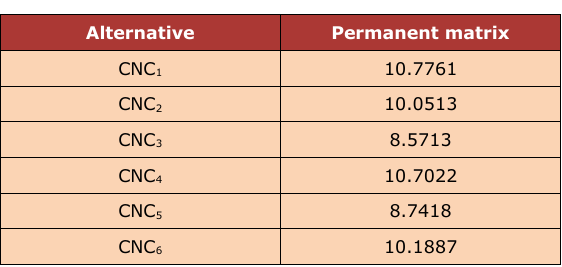
Table 16. Permanent matrix of each alternative